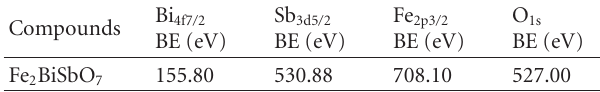
Table 2: Binding energies (BE) for key elements from Fe 2 BiSbO 7